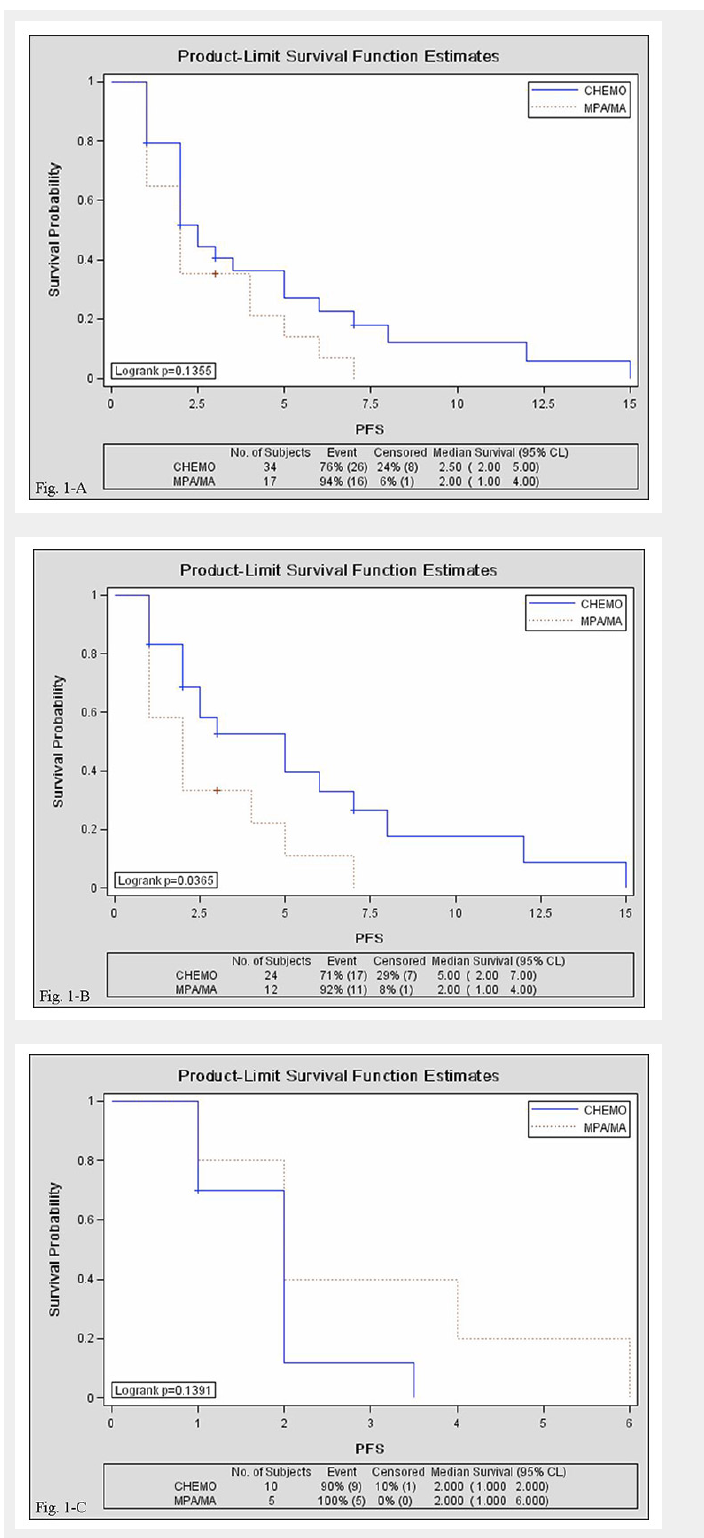
Figure 2 Kaplan–Meier curves for progression-free survival in the MPA/MA and chemotherapy groups. A, overall; B, 1–6 lines of salvage therapy; C, ≥7 lines of salvage therapy. CHEMO, chemotherapy group; MPA/MA, medroxyprogesterone acetate/megestrol acetate group; PFS, progression-free survival; CI, confidence